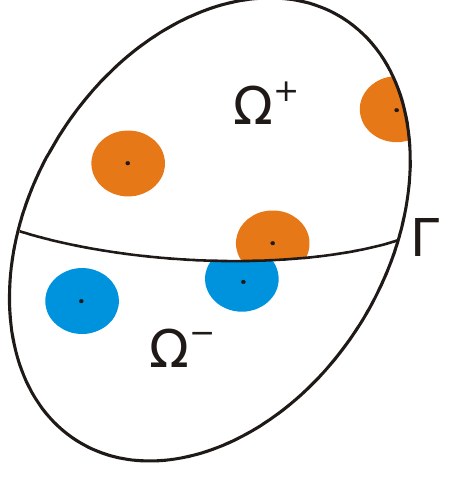
Figure 3. Sketch of the shape of nodal supports, either when they are wholly included in Ω or when they intersect the boundary of any